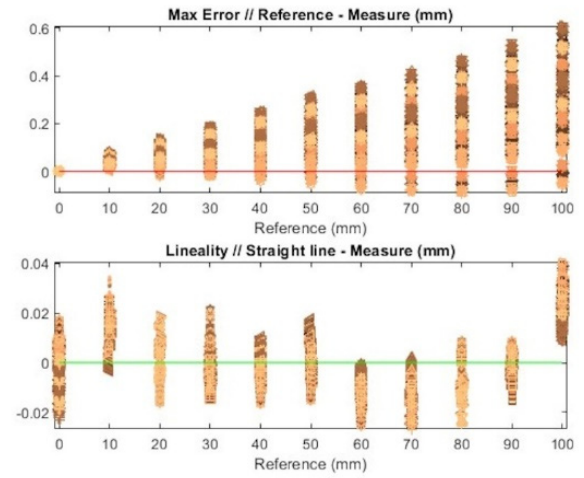
Figure 10. Maximum error and linearity for calibration combinations in block measurements between reference heights and obtained heights.